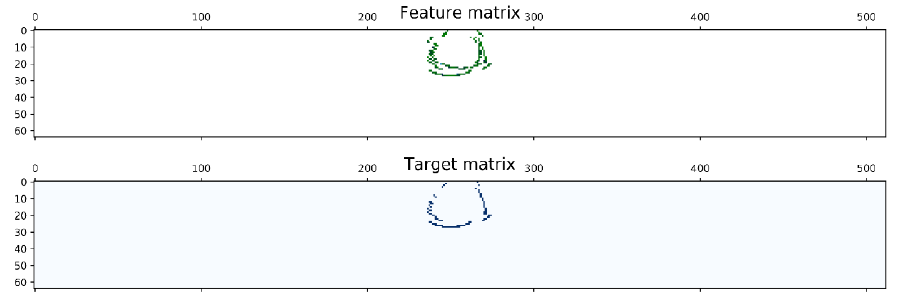
Fig. 5 . The feature and target matrixes of one